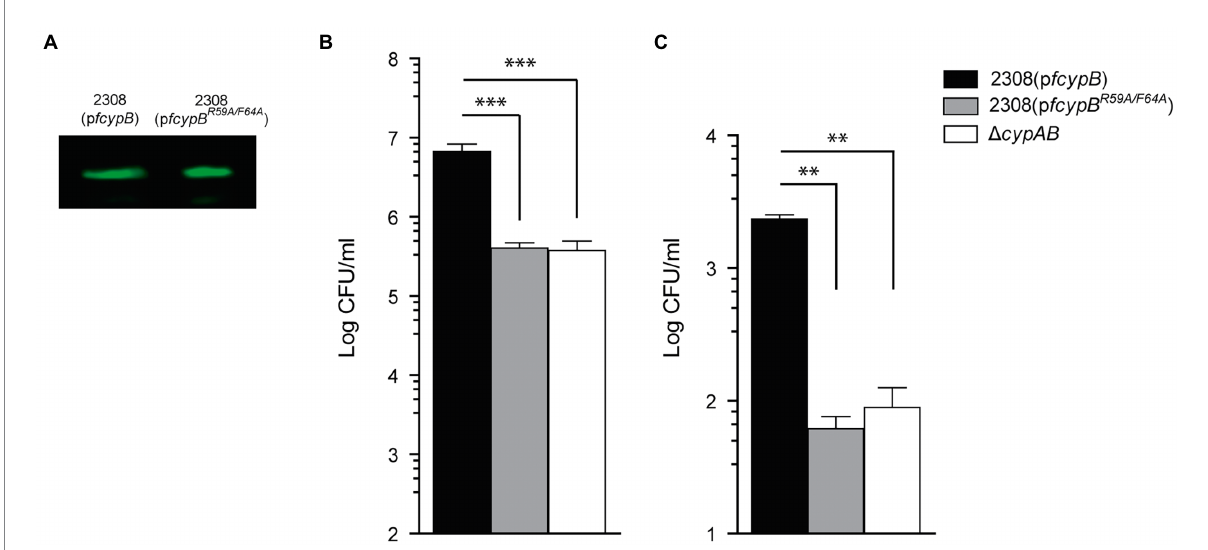
FIGURE 9 Dominant-negative mutation. (A) Western blot analysis of whole-cell lysates of B. abortus 2,308 strain expressing wild-type CypB, or CypB R59A/F64A detected by an anti-flag antibody. The strains were assayed for detergent sensitivity (DOC) (B) , and survival in HeLa cells (C) as described in “Materials and methods.” One-way ANOVA and Bonferroni’s Multiple Comparison Test were used to analyze the statistical significance of the results. The results shown are representative of three independent experiments, ** p < 0.01, *** p < 0.001.